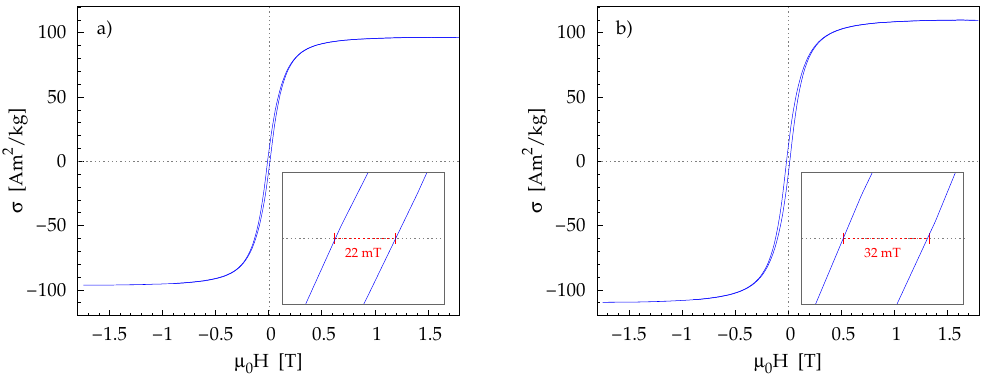
Figure 10. Room temperature hysteresis loop of ( a ) CoFeTaB and ( b ) CoFeWB alloys after 100h of milling traced in a magnetic field with maximum induction of µ 0 H = 1.8T. The insets show detailed view of hysteresis loop origin. The width of the loop is depicted with the red dashed line and corresponds to coercivity by relationship 2 µ 0 H c .